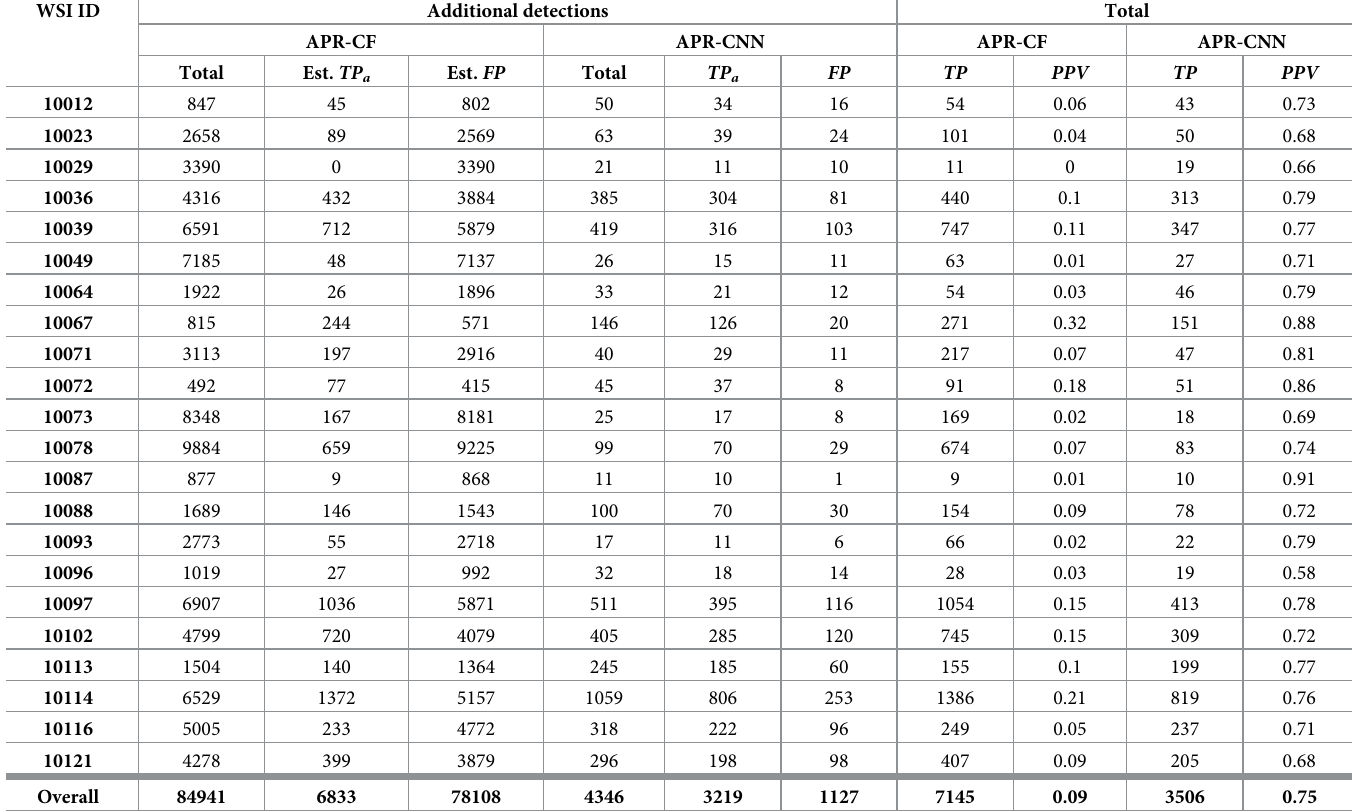
Table 4. Precision scores of the automatic